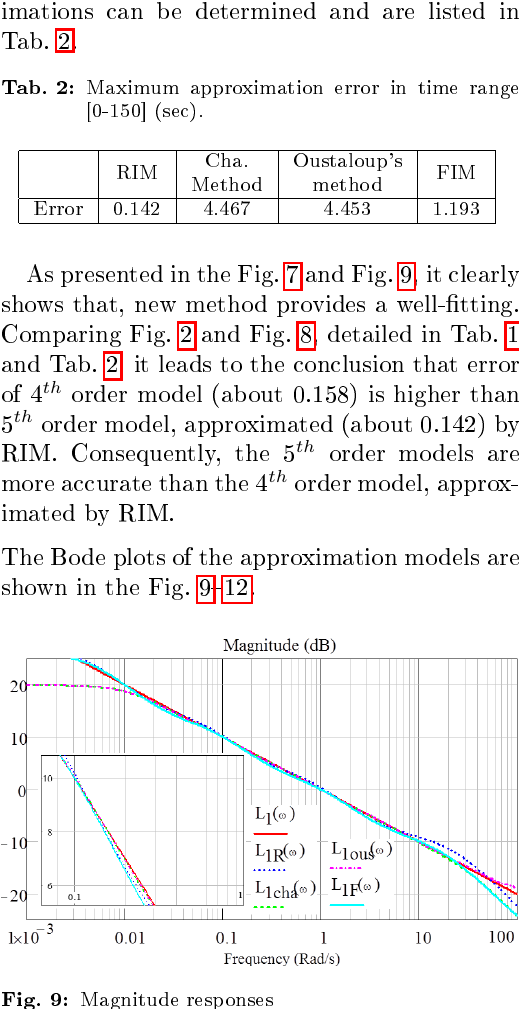
Fig. 9: Magnitude